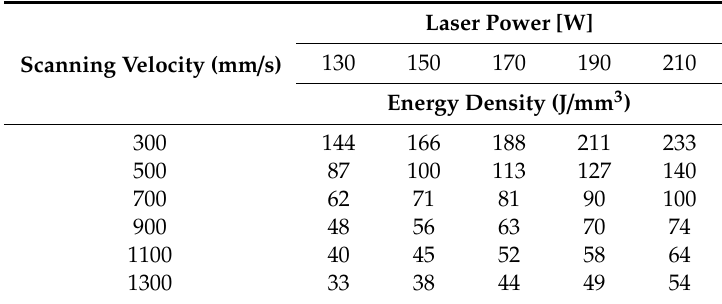
Table 2. Processing